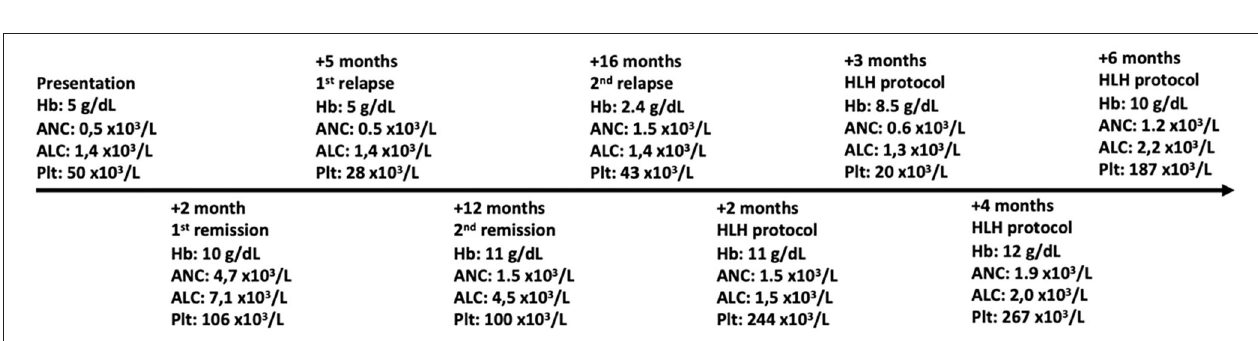
FIGURE 2 | Peripheral blood counts over time. Hb, hemoglobin; ANC, absolute neutrophil count; ALC, absolute lymphocyte count; Plt, platelet